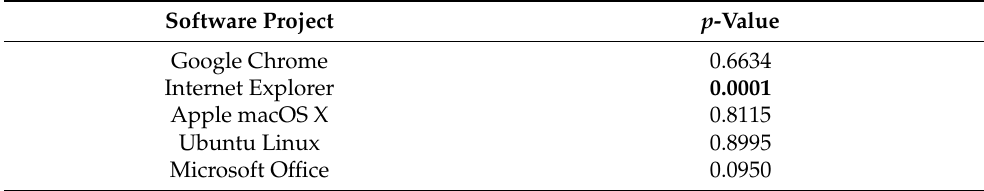
Table 10. Wilcoxon signed-rank test results of the best pairs of statistical and deep learning